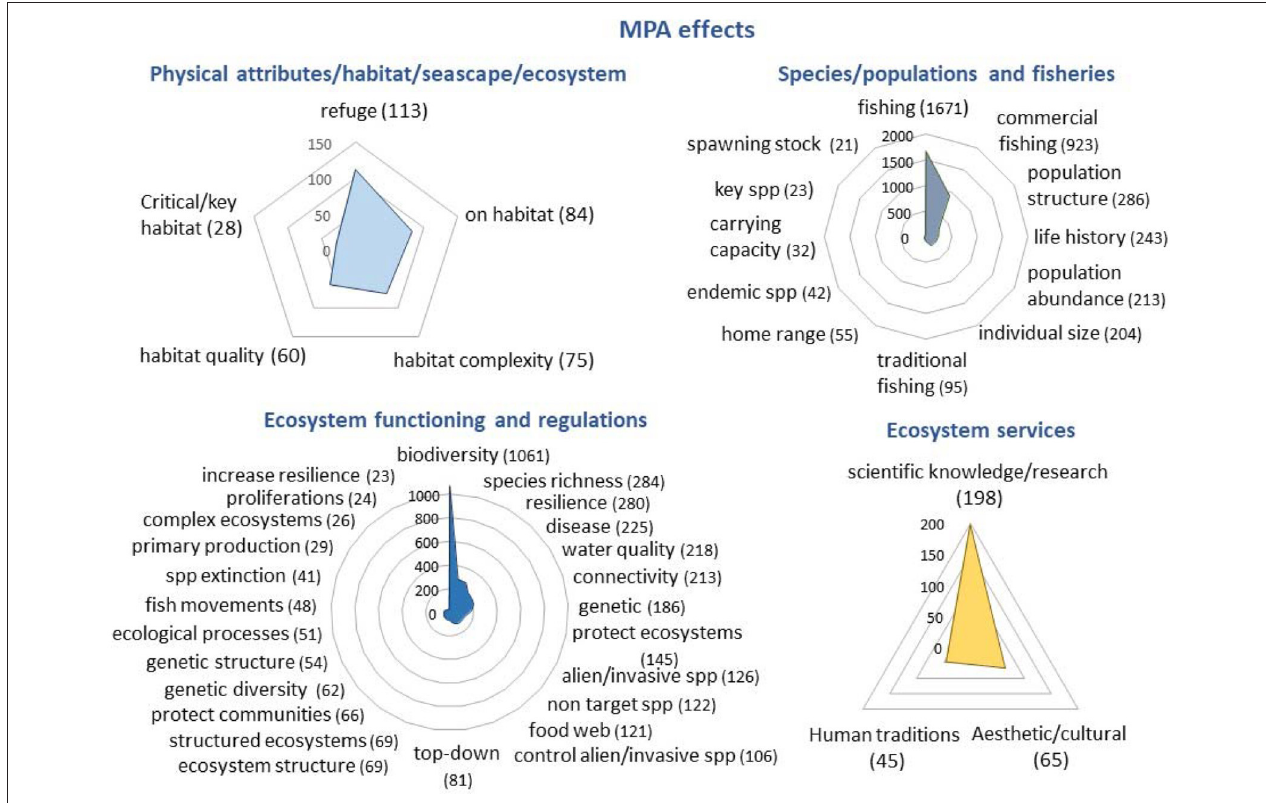
FIGURE 4 | Graphic representation of the occurrence (number of articles) of main protection effects in MPAs according to the articles recorded in the Web of Science. Only search terms exceeding 1% of the total number of articles including the term “effect” are